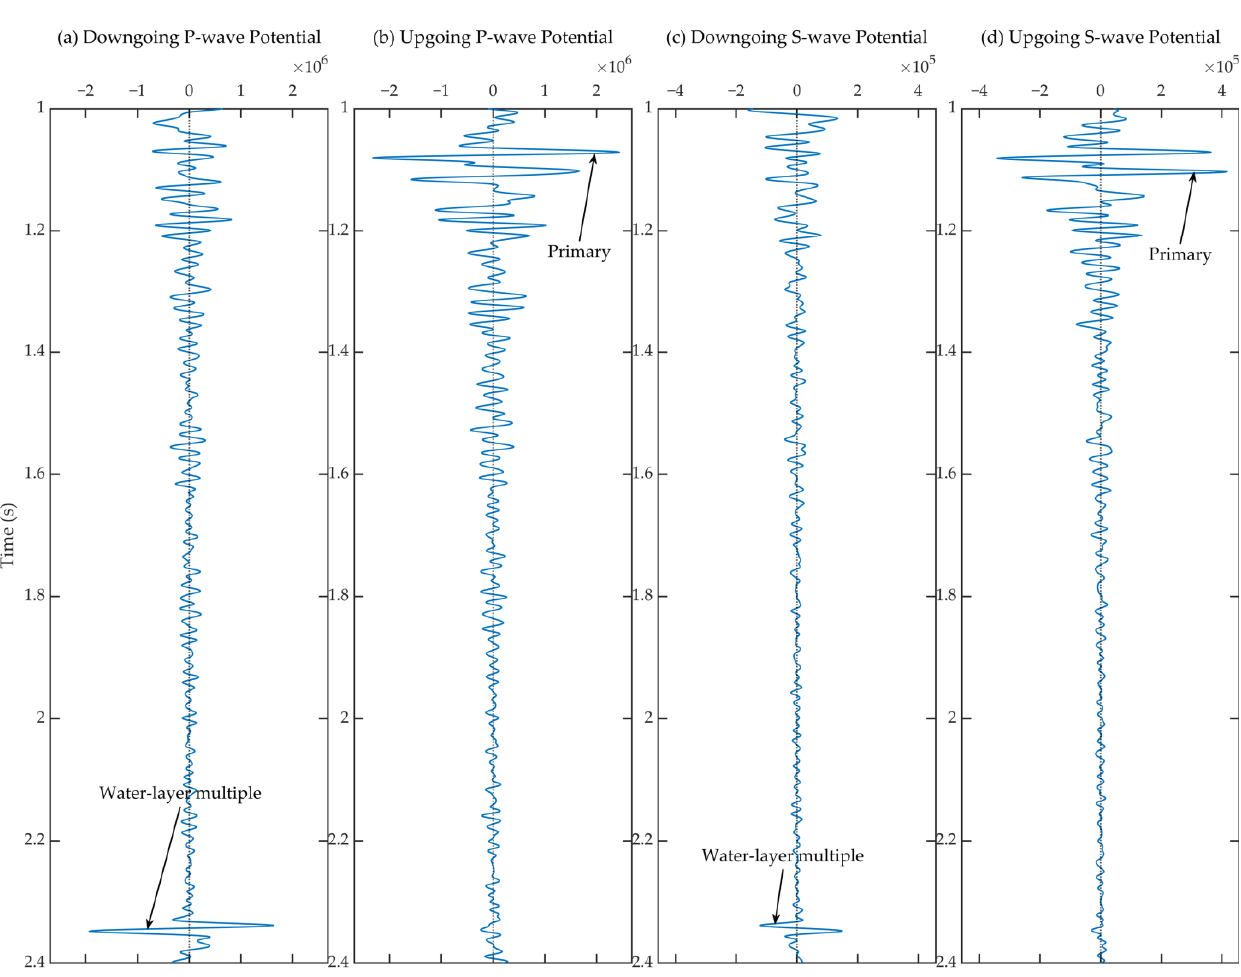
Figure 17. One-trace samples (the 300th trace, about 612.5 m in offsets) from the ( a ) downgoing P-potential, ( b ) upgoing P-potential, ( c ) downgoing S-potential, and ( d ) upgoing S-potential decom- posed just below the seafloor. Black arrows indicate representative peaks.